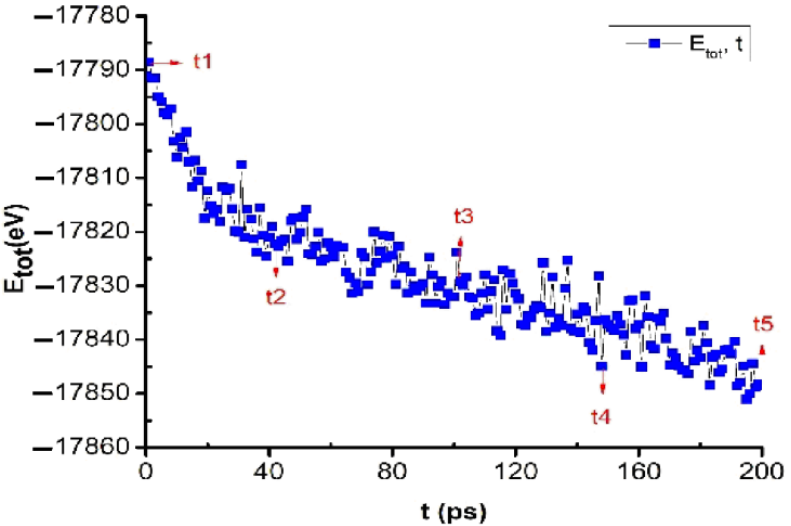
Figure 5. The crystalline phase transition of bulk Cu 5324 material at glass temperature T g = 652 K after annealing time t = 200 ps.